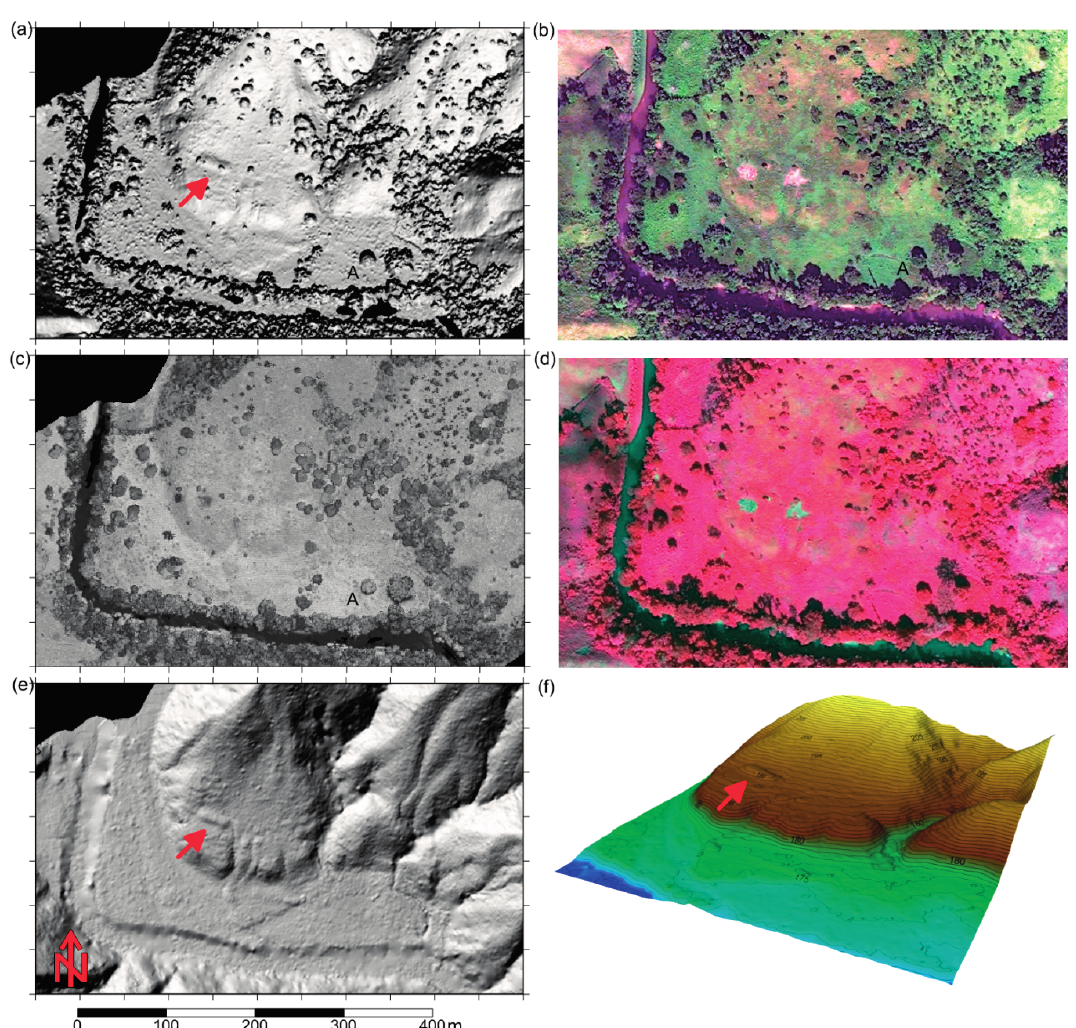
Figure 7. ( a ) Shaded relief map produced from a DSM; ( b ) Visible Satellite Image; ( c ) Image map from laser return intensity; ( d ) Visible-IR Satellite Image; ( e ) Shaded relief map produced from a DEM; ( f ) Perspective view overlaid with contour